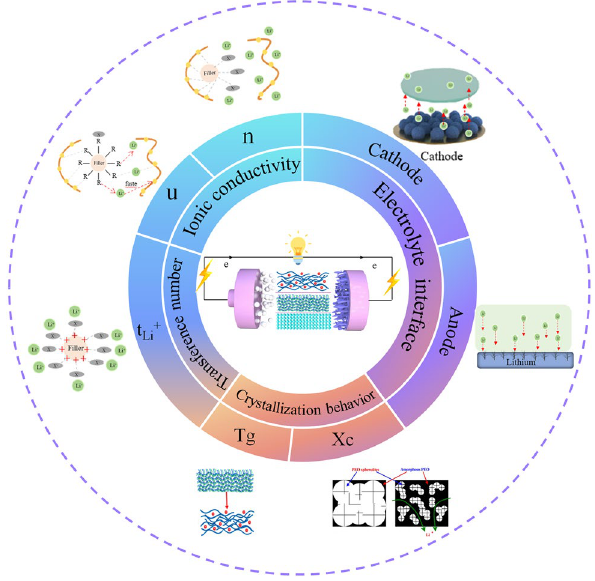
Fig. 7 Schematic of the effects of fillers in CPEs for lithium